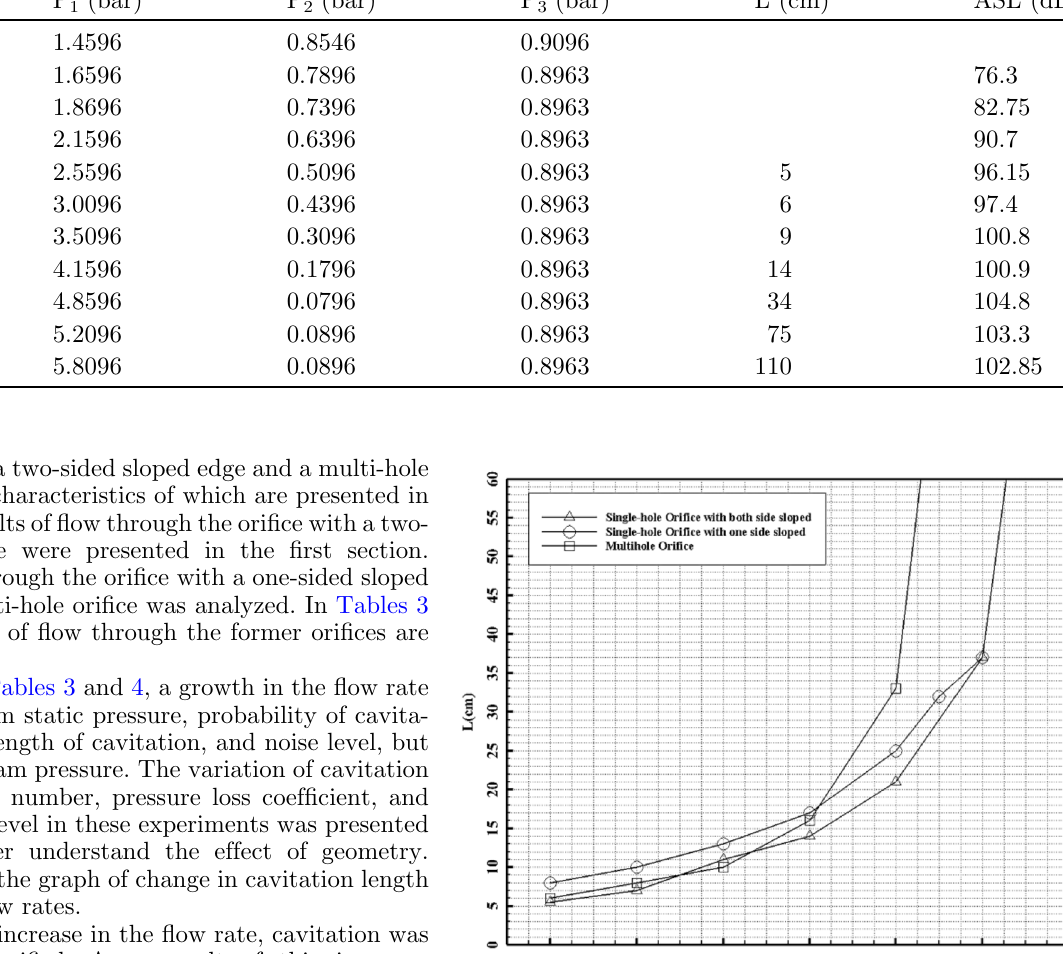
Table 4. The experimental results for the multi-hole ori fi ce with EDR = 0.4. Q (m 3 /h)